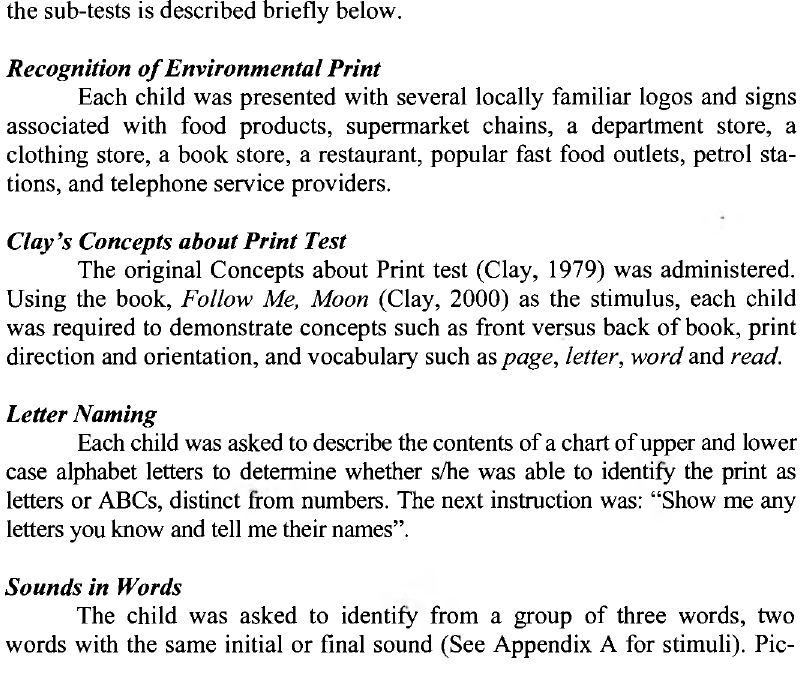
Table 1: Sub-Tests of the Emergent Literacy Assessment (ELLA) and the Corre­ sponding Domains of Emergent